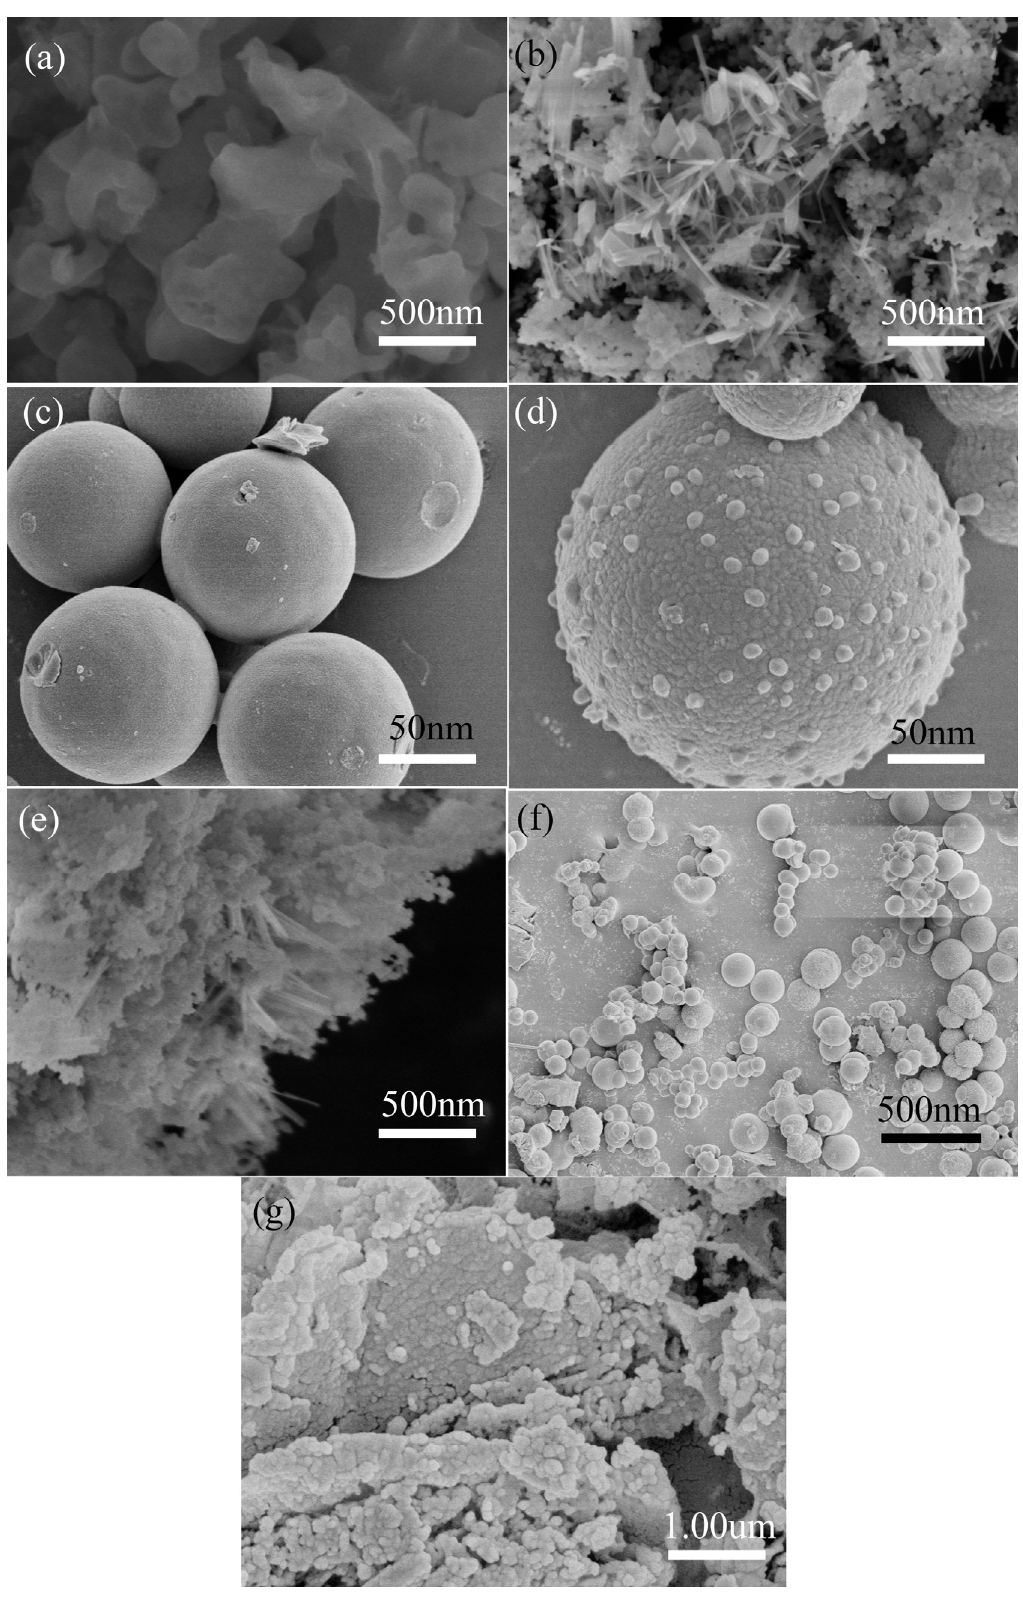
Figure 2. SEM images of all samples: ( a ) Pure LaVO 4 , ( b ) LaVO 4 /g-C 3 N 4 , ( c ) Pure LaFeO 3 , ( d ) LaFeO 3 /g-C 3 N 4 , ( e ) Pure LaCoO 3 , ( f ) LaCoO 3 /g-C 3 N 4 and ( g ) Pure g-C 3 N 4 .